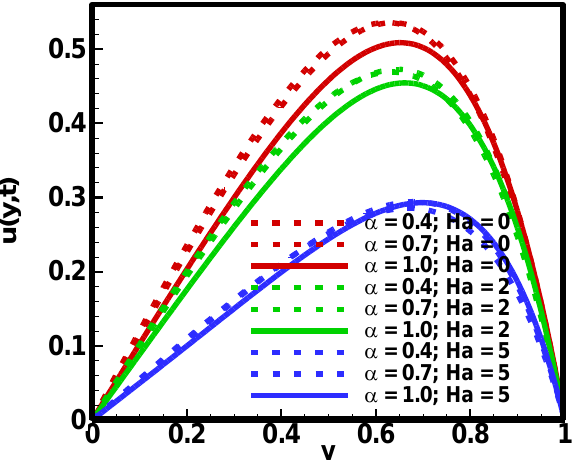
= 0.1, Gr = 5, λ β = 0.1, Pr = 21, 2 1